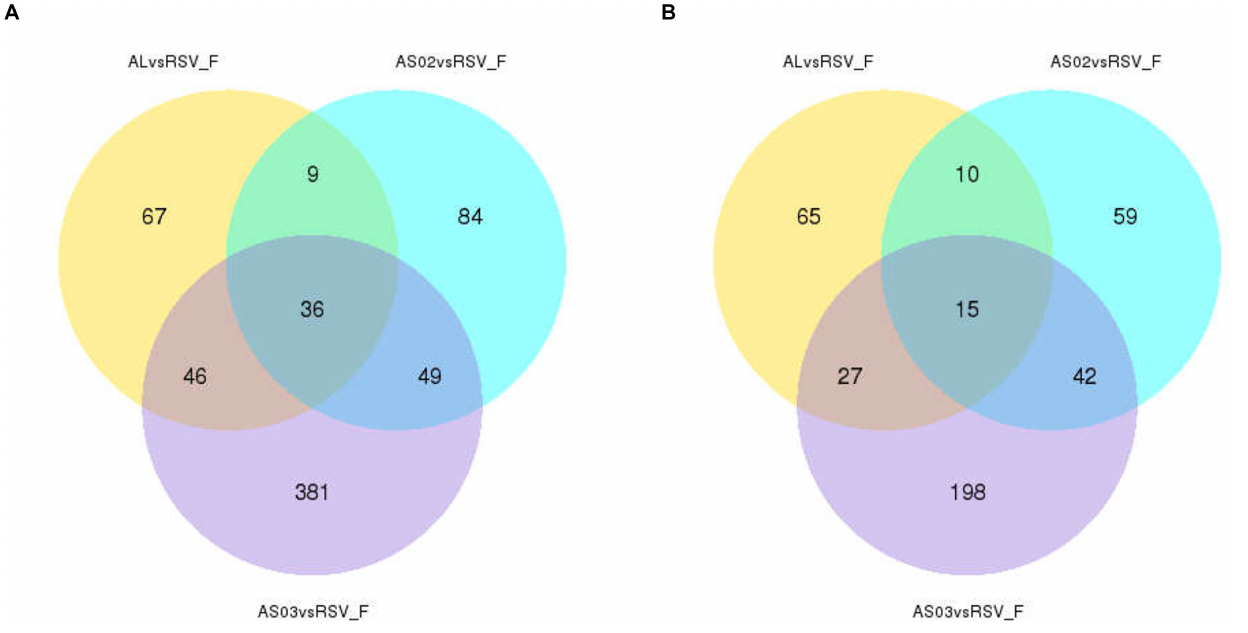
FIGURE 8 | Overlap of immune-related differentially expressed genes (DEGs) among adjuvant groups contrasted with the RSV-F-only group. The number of up- (A) and down- (B) regulated DEGs in the adjuvant group was shown separately. For the description of the genes differentially expressed, please refer to Supplementary Table S3 (VENN DOWN-regulated) and Supplementary Table S4 (VENN